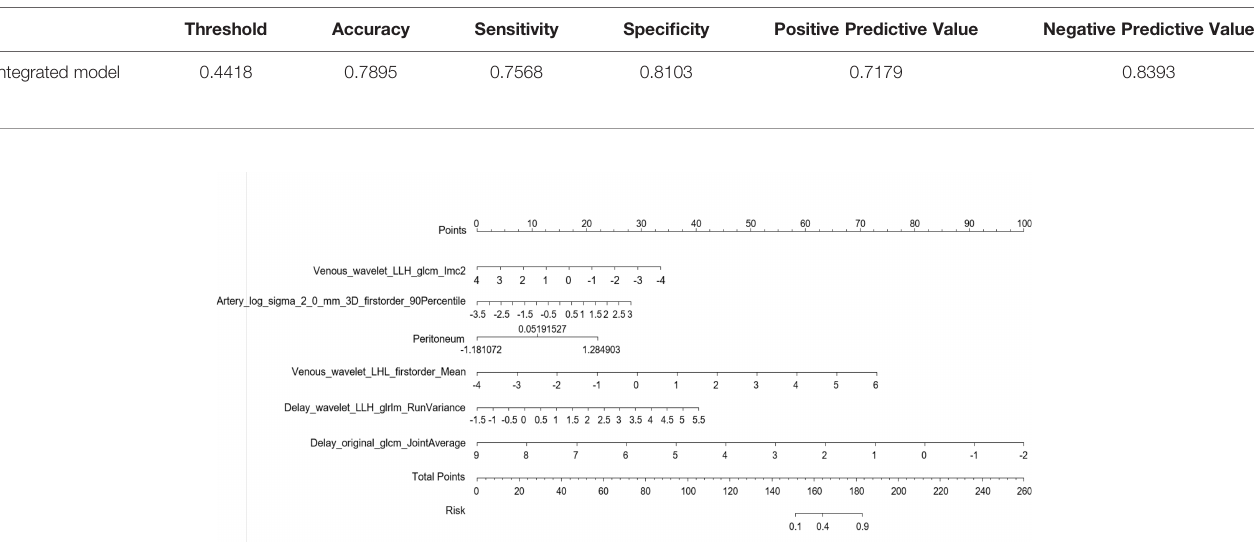
FIGURE 6 | Establishment of a nomogram risk model to predict BRCA gene mutation status in epithelial ovarian cancer.